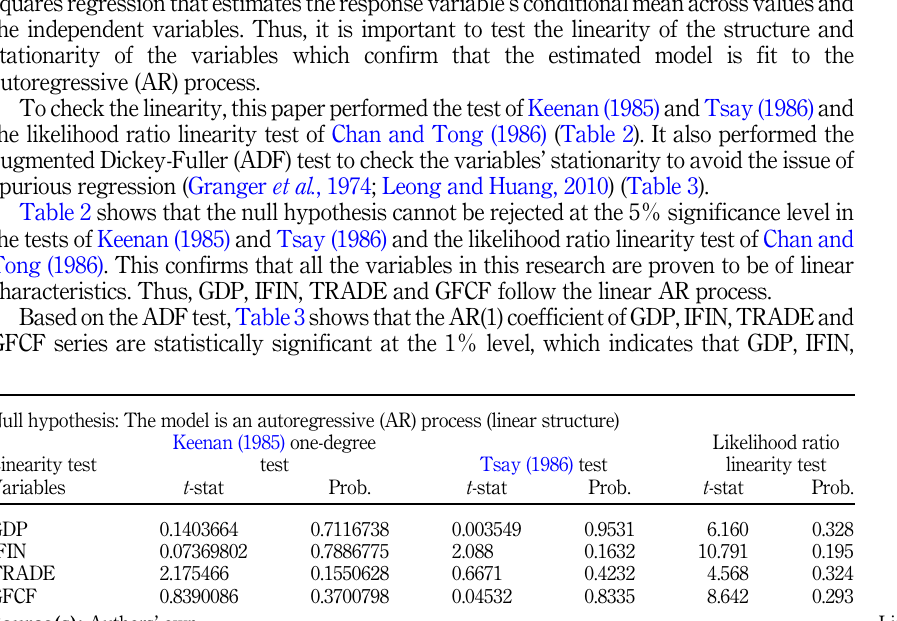
Table 2. Linearity test